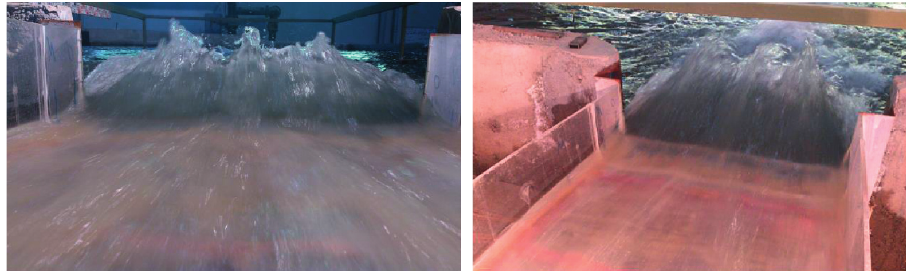
Figure 3: Interaction effect of jet flow with shockwaves in flip bucket area.